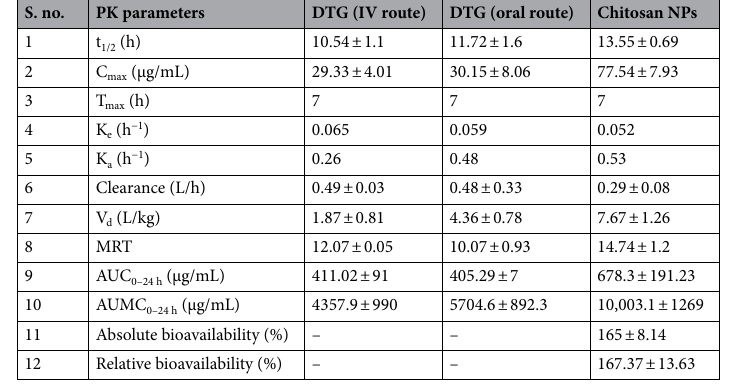
Table 1. Pharmacokinetic parameters of the treated animals with pure DTG and Chitosan NPS.